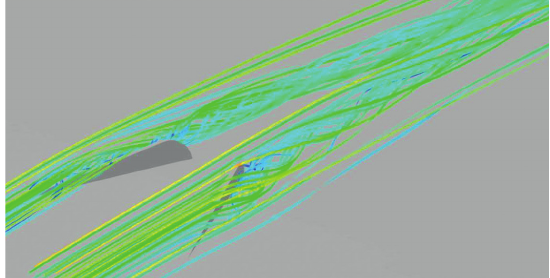
Figure 15. Perspective view of the longitudinal vortices generated by the VG in Re c = 2.38 × 10 5 and AoA = 3. The simulation in AoA = 6 showed that the recirculation bubble directly falls on the VG, which hinders the generation of vortices since the flow loses energy due to recirculation, this becomes more evident analyzing Figs. 12 and 16 (in comparison with profile without VG in Fig. 13), in which the velocity profiles are presented, in these conditions the emergence of well-defined vortex structures was not observed.